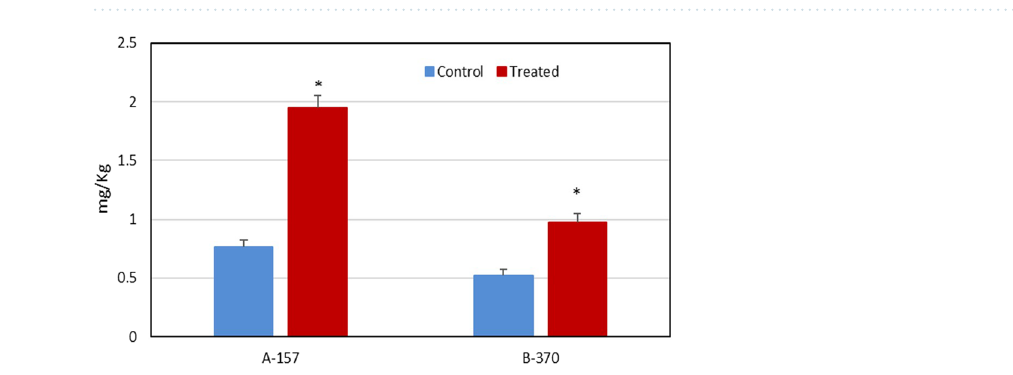
Figure 5. Analysis of ( A ) BADH2 enzyme assay ( B ) BADH2 gene expression ( C ) GABA ( D ) Methylglyoxal in leaf tissue of aromatic rice cultivars grown under control and salt stress.